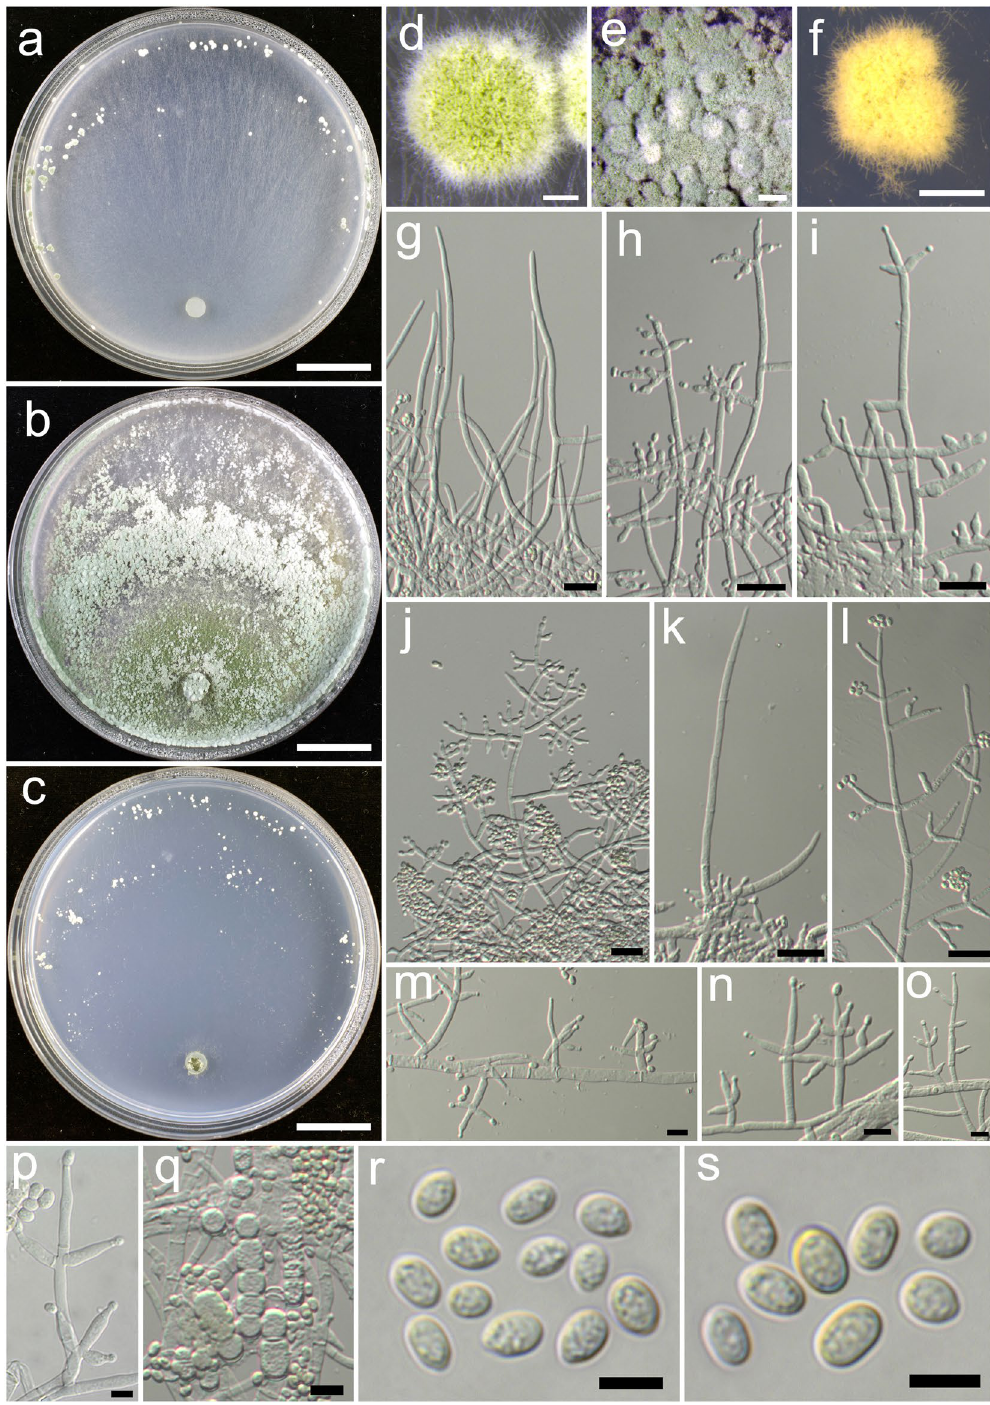
Figure 8. Trichoderma chlamydosporicum (HMAS 248850). ( a – c ) Cultures at 25 °C, 7 d (a. on CMD; b. on PDA; c. on SNA); ( d – f ) Conidial pustules (d. CMD, 7 d; e. PDA, 7 d; f. SNA, 7 d); ( g – k ) pachybasium-like conidiophores and phialides (PDA, 6 d); ( l – p ) Verticillium-like synanamorph (PDA, 5 d); ( q ) Chlamydospores (PDA, 5 d); ( r , s ) Conidia (PDA, 5 d). Bars: a–c = 20 mm. d = 300 μ m. e = 800 μ m. f = 400 μ m. g–l = 20 μ m. m–q = 10 μ m. r–s = 5 μ